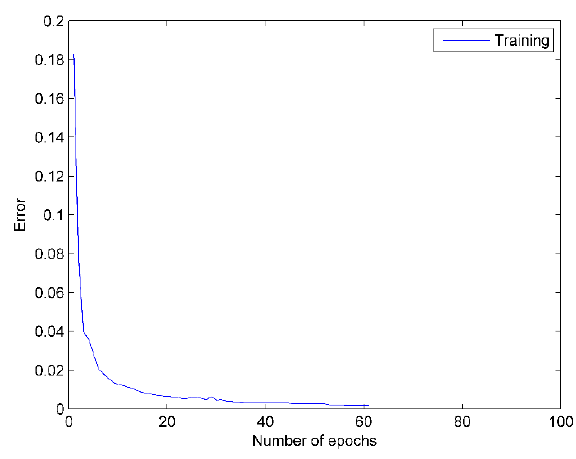
Figure 9. DBN error curve. The blue line represents the training error of each epoch.